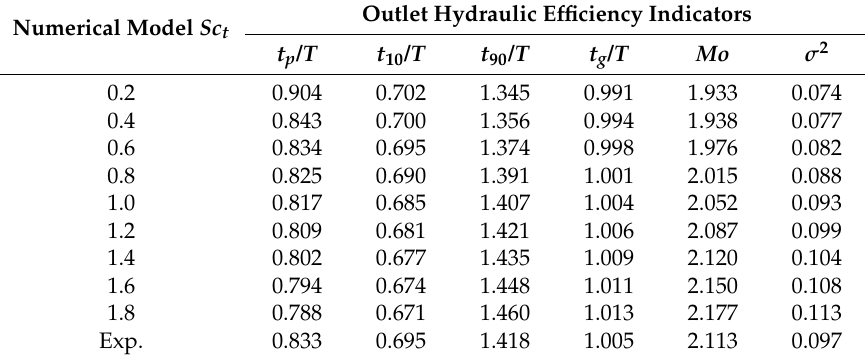
Table 5. Hydraulic efficiency indicators values drawn from numerical model predictions where Sc t values are in the range of 0.2–1.8 and the tracer experiment study results,